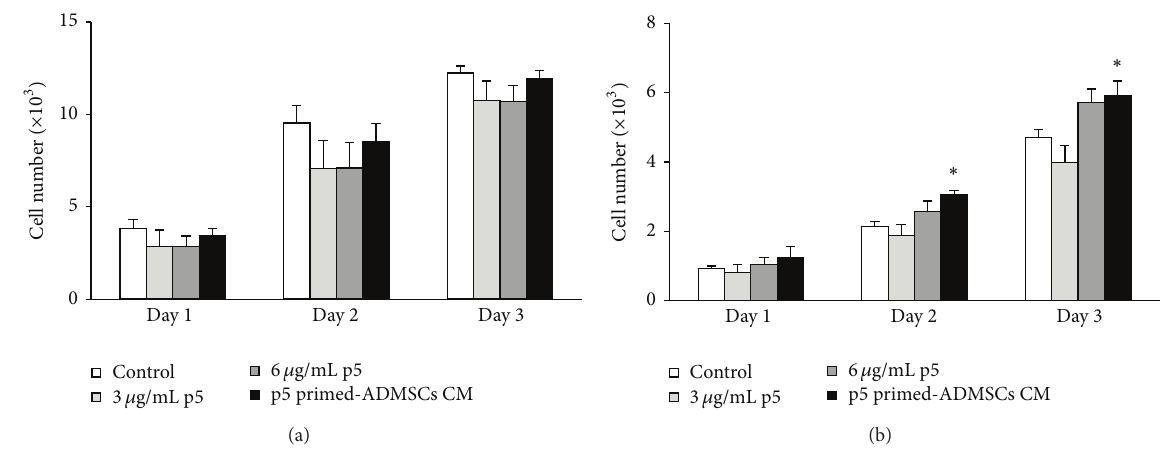
Figure 5: p5 and conditioned medium (CM) from p5-primed hADMSCs protected BAECs from calpain-induced cytotoxicity. The cultured BAECs were treated with p5 or CM from 12 𝜇 g/mL p5-primed hADMSCs collected on Day 1 for 1 hour and then further treated with 5 𝜇 M calcium ionophore A23187 and 2.5 mM CaCl 2 for 10 minutes (a) or 2 hours (b). The cell proliferation was monitored for 3 consecutive days using the alamarBlue assay. Data are means ± SD (error bars). Significance (denoted as ∗ ) was calculated compared to the control using Student’s 𝑡 -test (with 𝑝 < 0.05, 𝑛 =